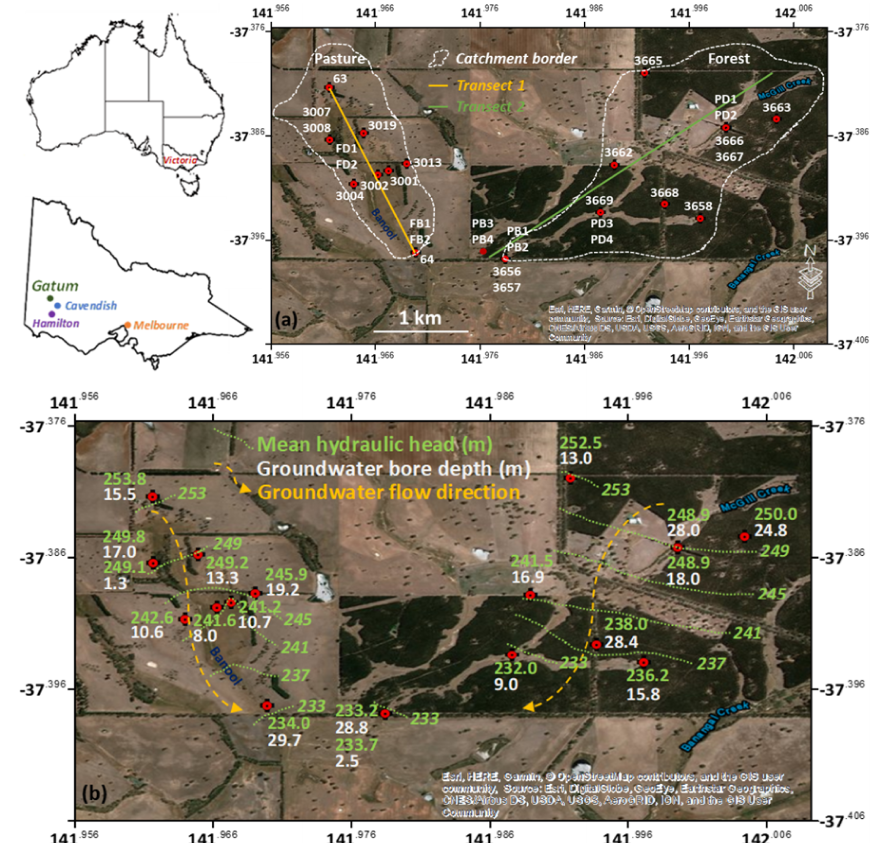
Figure 1. (a) Map of the Gatum pasture and forest catchments with the locations of groundwater bores (3007 and 3008, 3666 and 3667, and 3656 and 3657 are nested bores); shallow piezometers are at PD (pasture drainage zone), PB (pasture lower slope), FD (forest drainage zone) and FB (forest lower slope). The catchment boundaries for the streams are from Dresel et al. (2018). (b) Mean hydraulic heads of groundwater from 2010 to 2017 except for 3008 (from 2010 to 2015) and 3658 (from 2010 to 2016) with sample depths and flow directions. Background ArcGIS ® 10.5 image (Esri, HERE, Garmin, © OpenStreetMap contributors and the GIS User Community, Source: Esri,